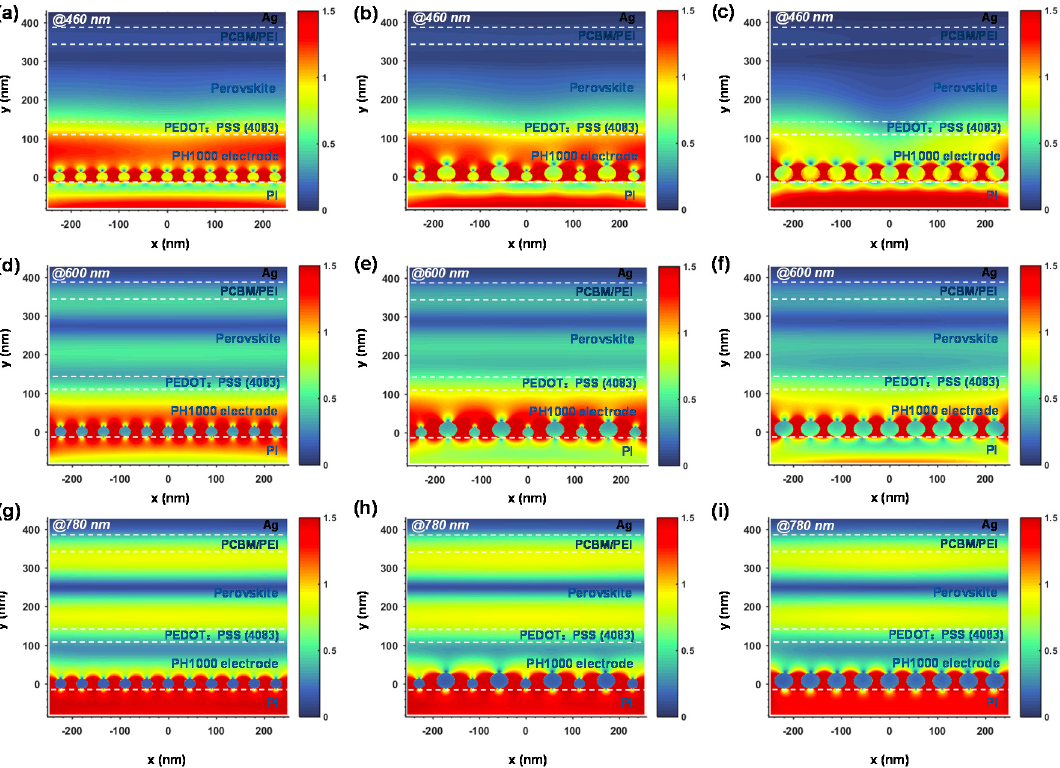
Figure 5. Simulated cross-section near-field distributions for TE-polarized incident light at 460 nm (top row), 600 nm (middle row), and 780 nm (bottom row) in PSCs on PI substrates with ( a – c ) Ag (~25 nm), ( d – f ) Ag (~25/40 nm), and ( g – i ) Ag (~25/40 nm).